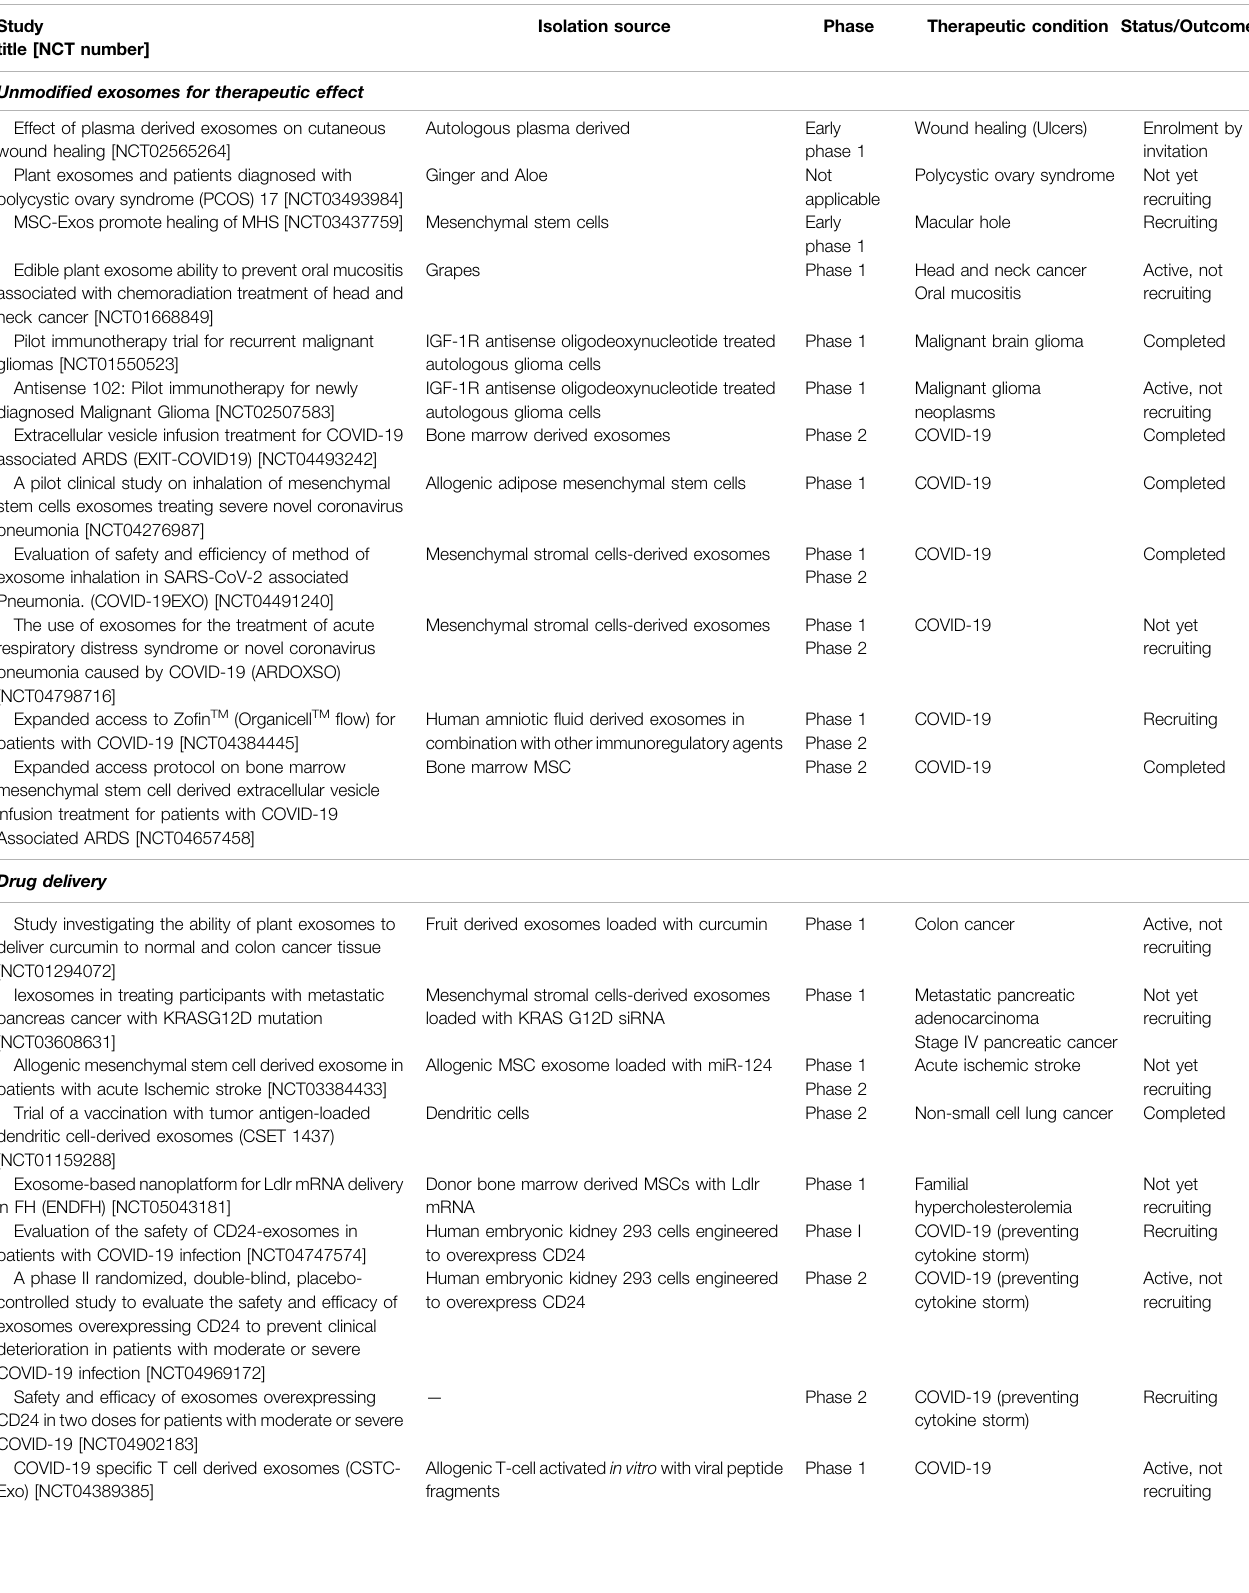
TABLE 3 | Clinical trials utilizing exosomes for therapeutic bene fi ts and drug delivery